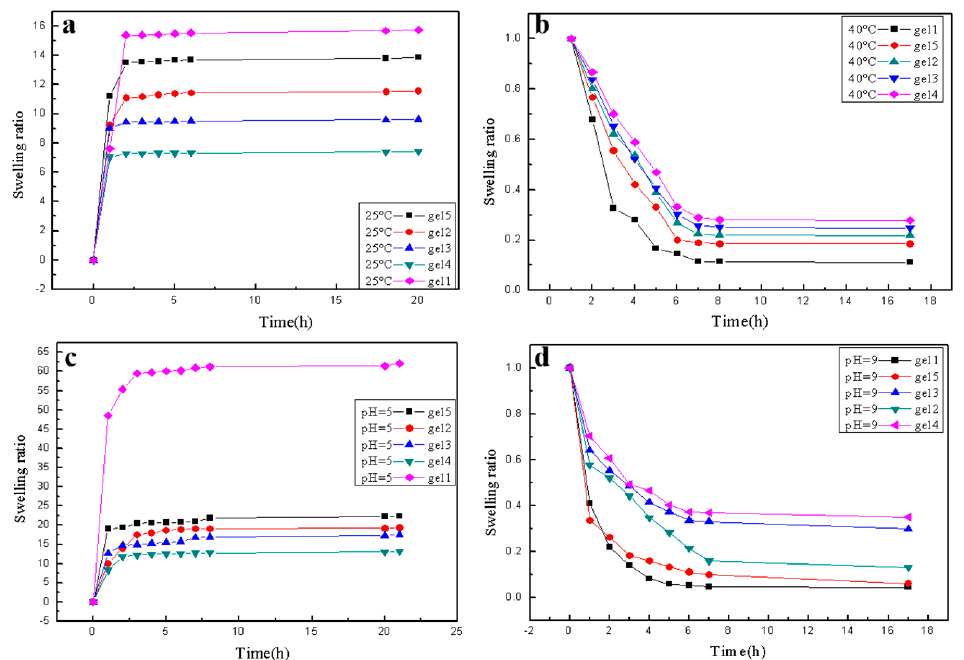
Figure 3. Swelling ratios of hydrogels ( a ) at 25 °C, pH = 7. ( b ) at 40 °C pH = 7. ( c ) at 25 °C, pH = 5, ( d ) at 25 °C, pH = 9.